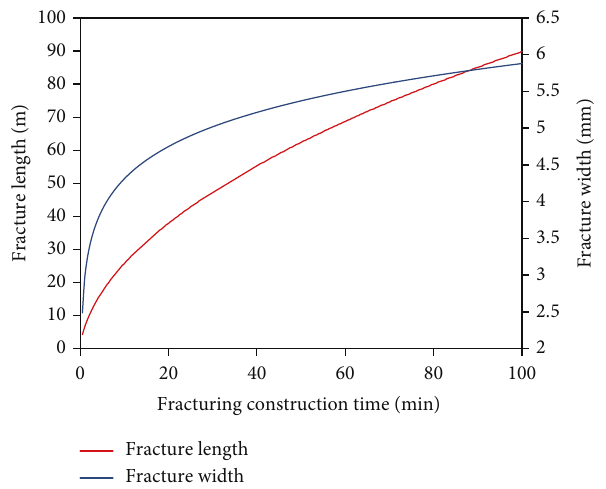
Figure 9: Fracture morphology of carbon dioxide foam fracturing (displacement 4.0 m 3